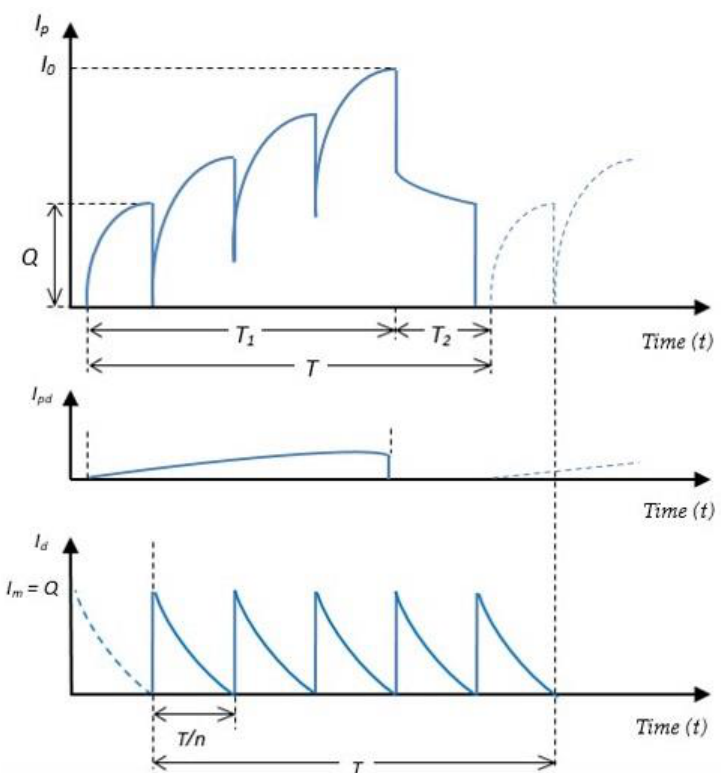
Figure 7. Manufacturer’s and retailer’s inventory model for constant deteriorating items with manufacturer’s inspection for n = 5.